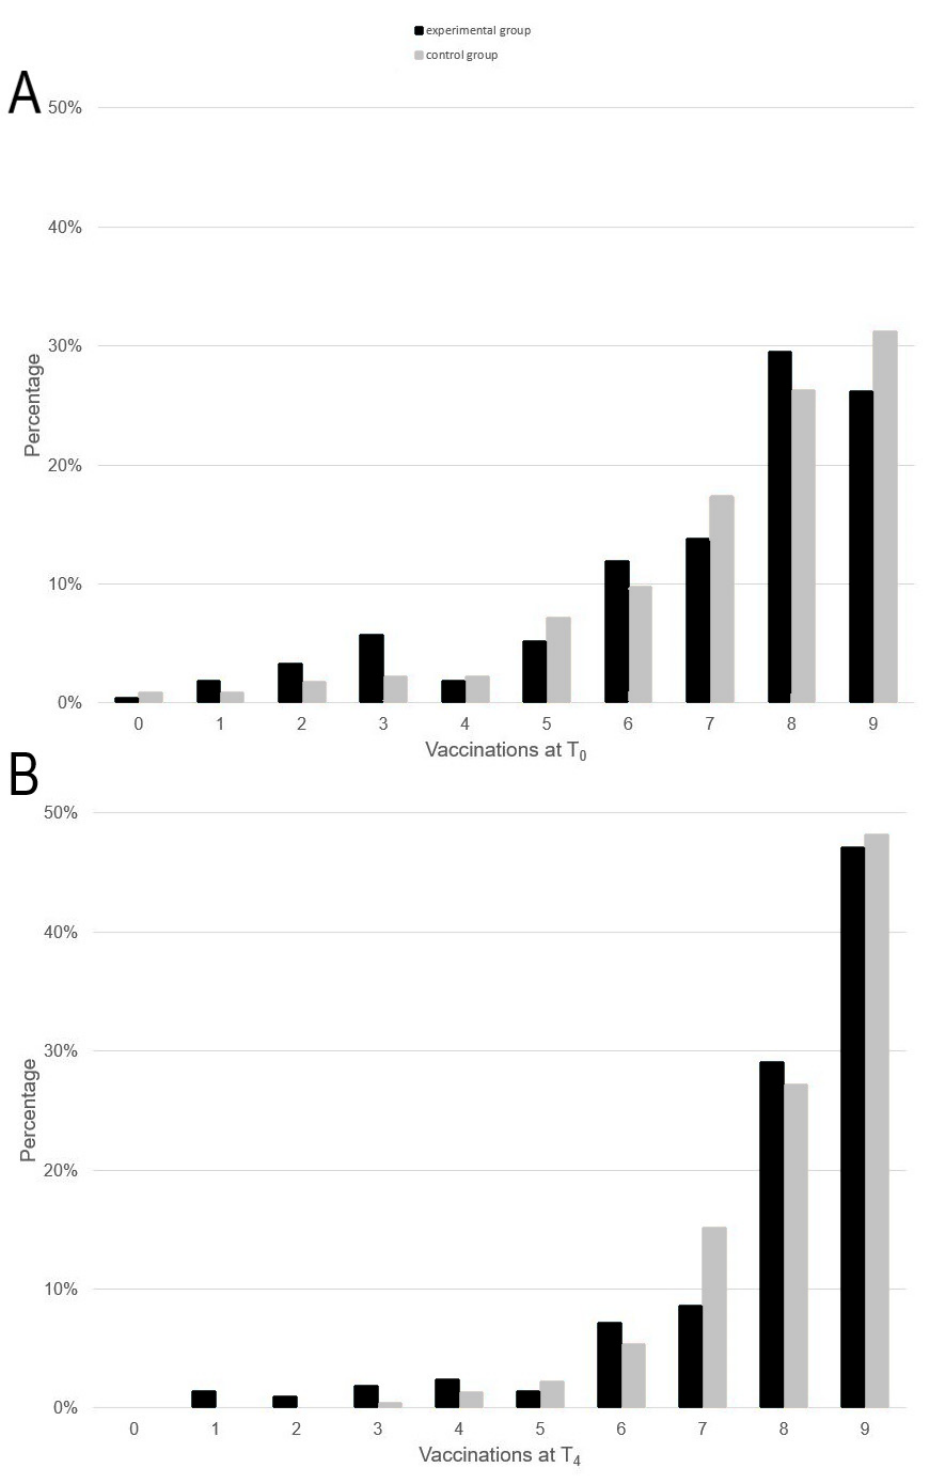
Figure 2. Development of full immunisation against the diseases applicable to assistance and disaster relief operations at home (tetanus, diphtheria, polio, pertussis, measles, mumps, rubella, hepatitis A, hepatitis B, tick-borne encephalitis, influenza) during the study period, X-axes show the number of full immunisations, maximum 9 ( A = vaccinations at beginning of the study (T0), B = vaccinations at the end of the study (T4)).